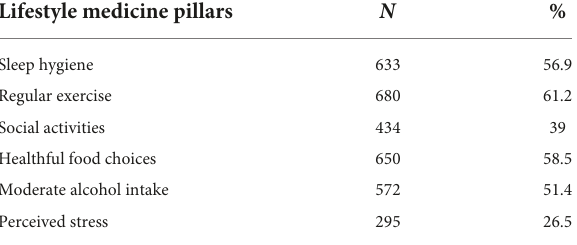
TABLE 1 Participants’ prevalence of engaging with lifestyle medicine (LM)